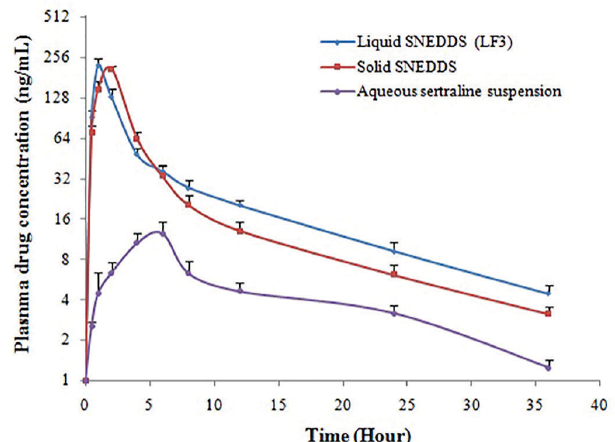
FIGURE 9 - Mean plasma concentration profile of sertraline after oral administration of liquid (LF3) and solid SNEDDS, aqueous suspension of plain sertraline. Data are expressed as mean (n = 3).